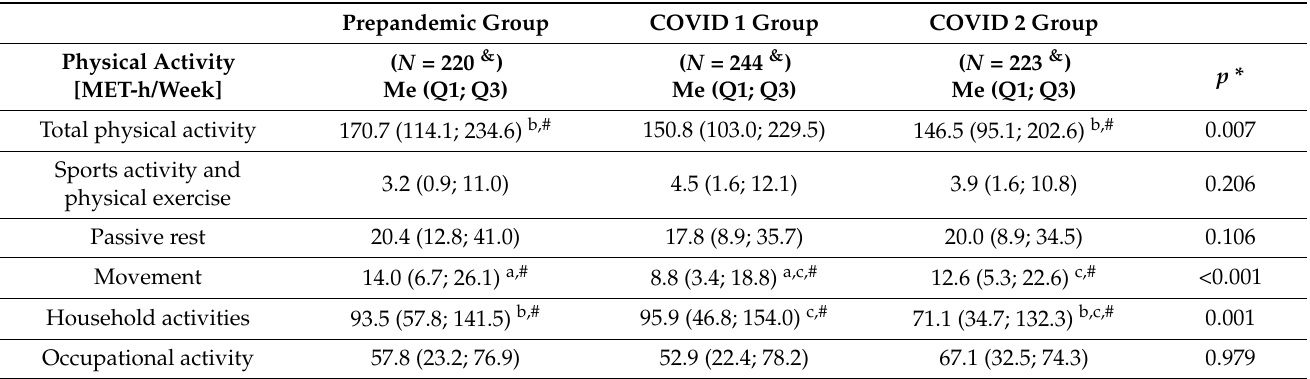
Table 2. The Level of Physical Activity in the Studied